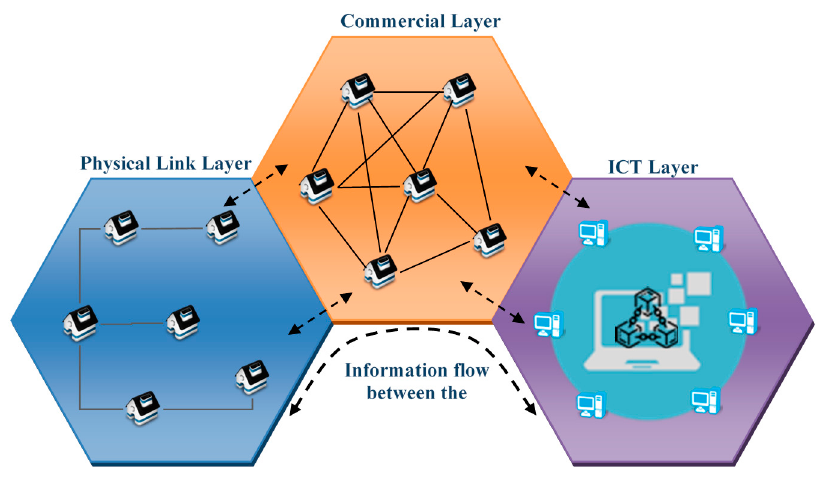
Figure 2. Di ff erent layers in the proposed model. Figure 2. Different layers in the proposed model.